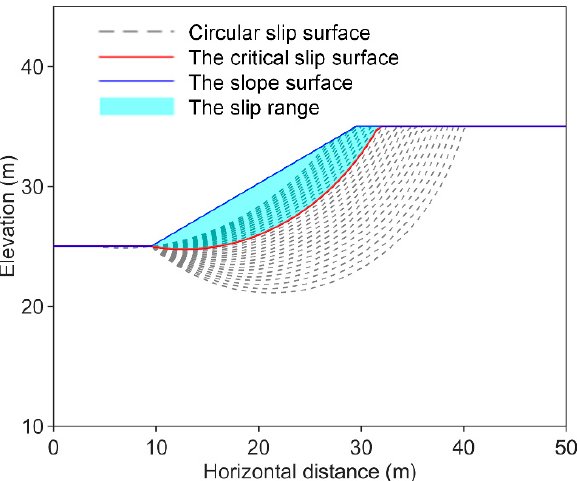
Figure 2. Critical slip surface of the circle shape searched by the Swedish method.